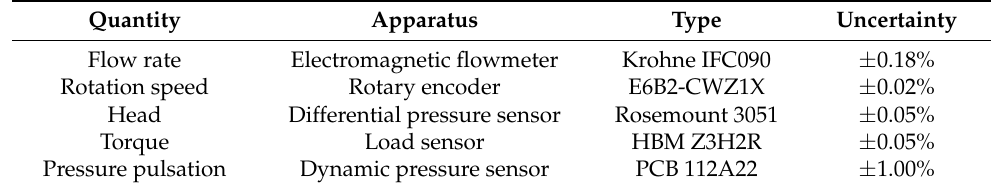
Table 2. Test instruments and